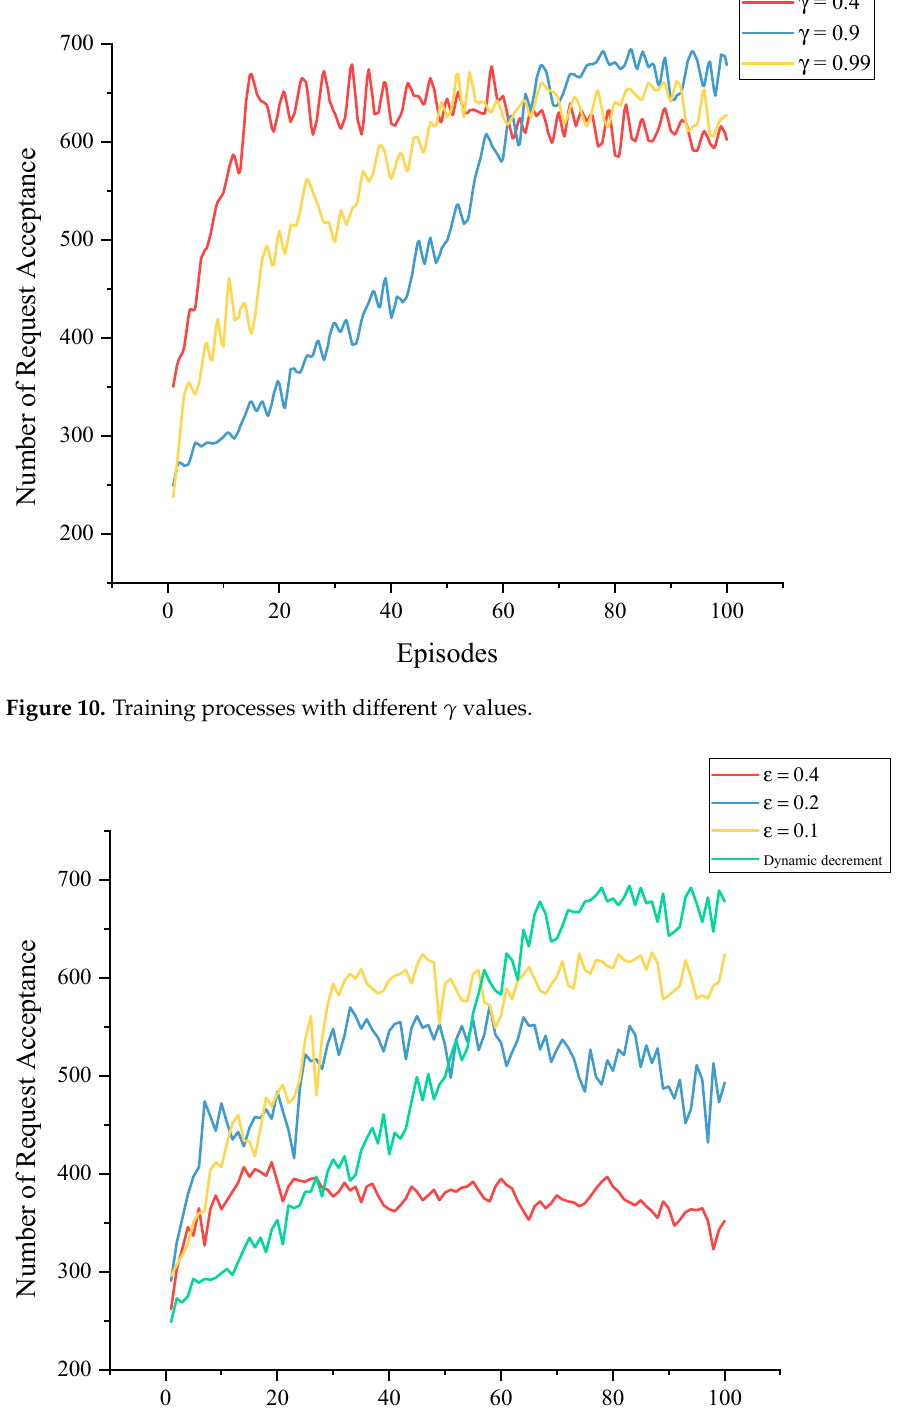
Figure 11. Training processes with different ε